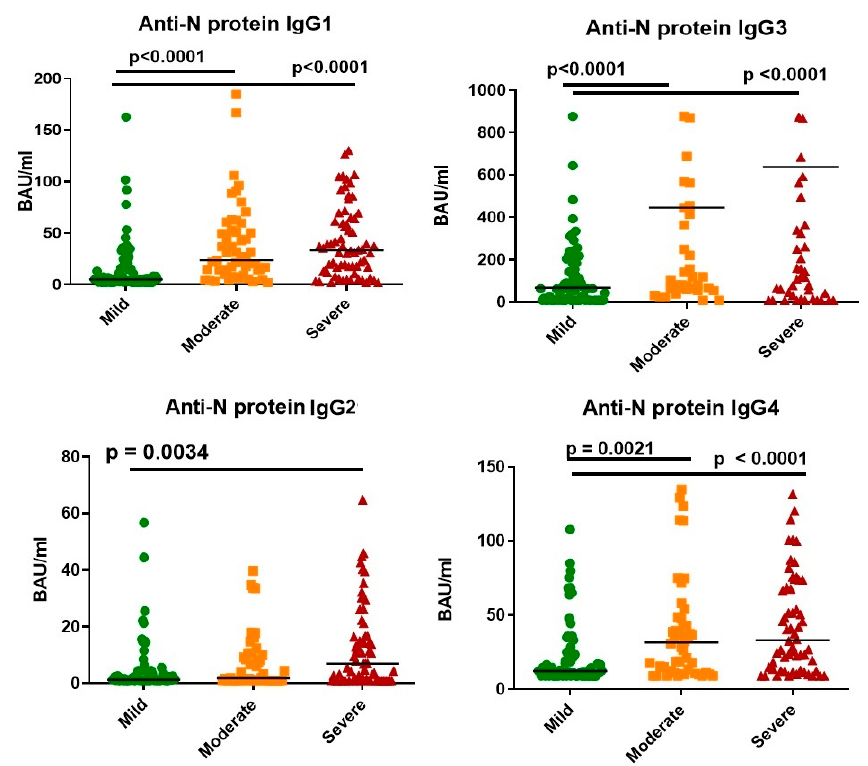
Figure 3. Differences in anti-N protein IgG subclass concentration depending on illness severity, Me (Q25–Q75).